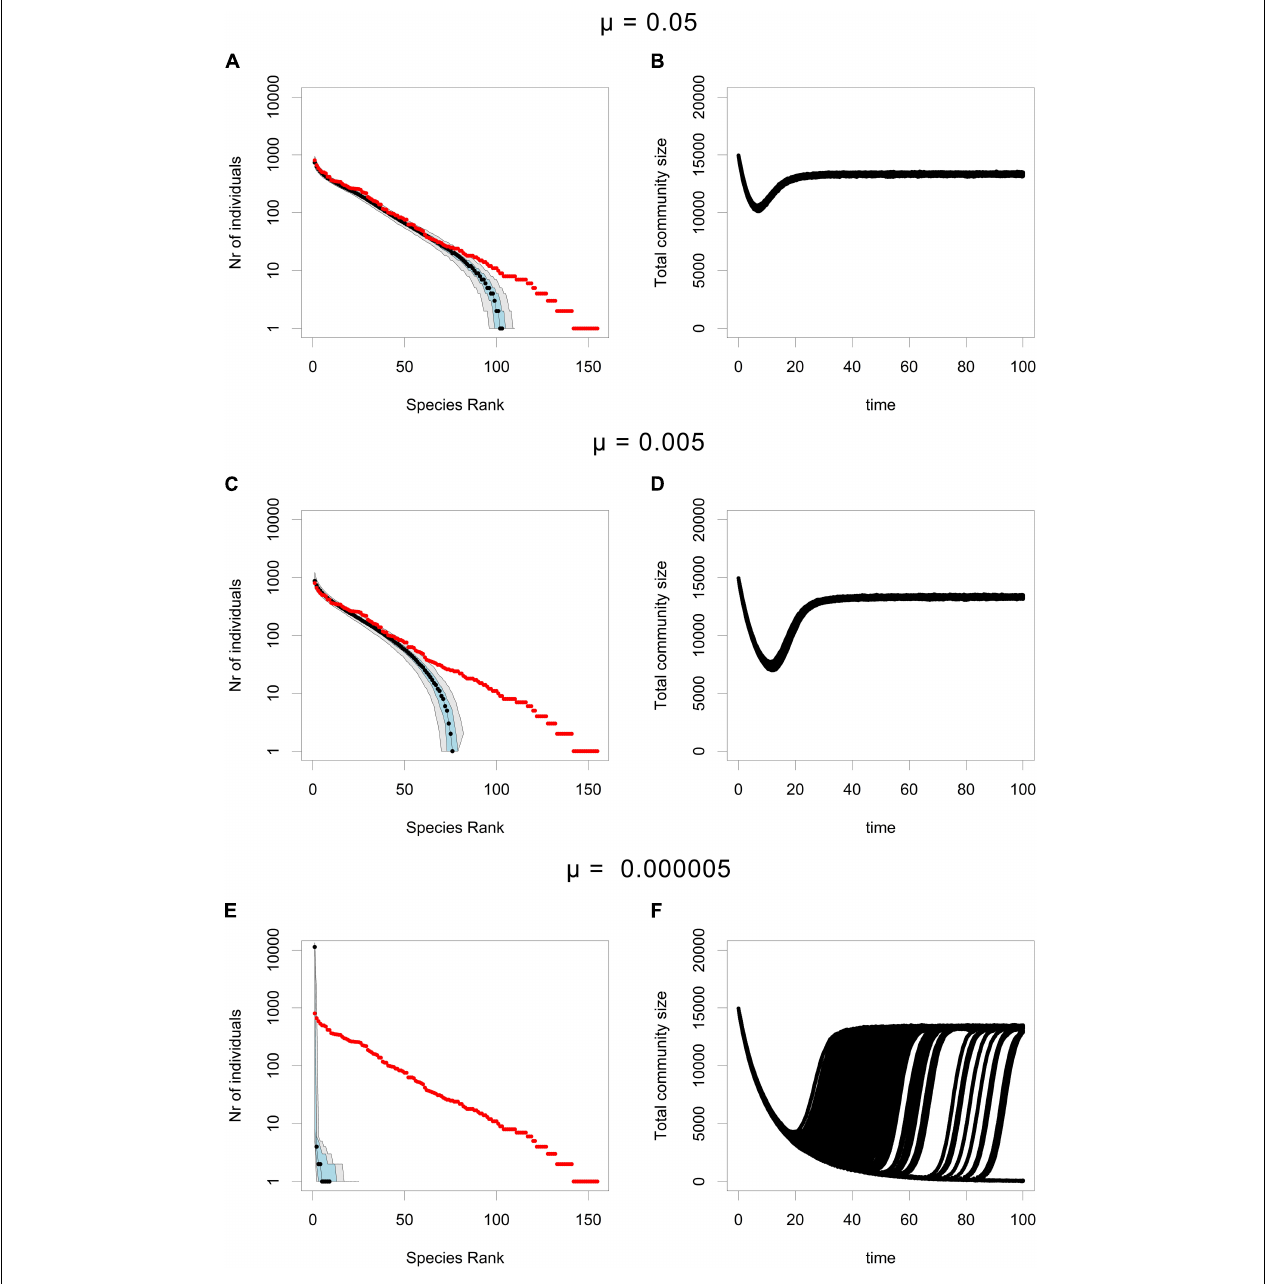
FIGURE 3 | RACs (A,C,E) and total community size trajectories (B,D,F) under the CWR process, for different mutation probabilities ( µ ), for each different mutation rate 500 simulations were performed. In the RAC plots the median is shown in black, the 25th and the 75th percentile are shown in blue, the 5th and the 95th percentile are shown in gray and the initial community is plotted in red. Simulations were performed using the parameters b 0 , res = 0.05, b 0 , mut = 0.6, d = 0.1, and K = 16000. For (A,B) µ = 0.05, in (C,D) µ = 0.005, and in (E,F) µ = 0.000005. The total community size trajectories were plotted for of each of the 500 simulations, hence the separation of these trajectories at low mutation rates (F)